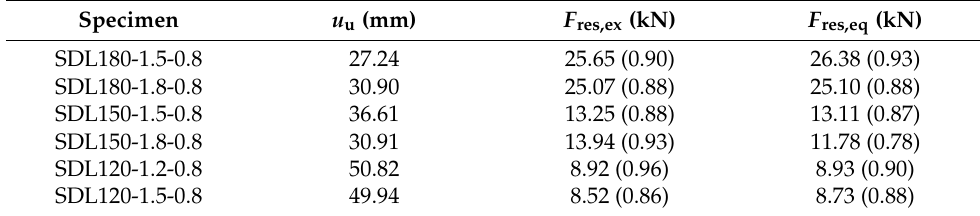
Table 4. Results of residual capacity test.